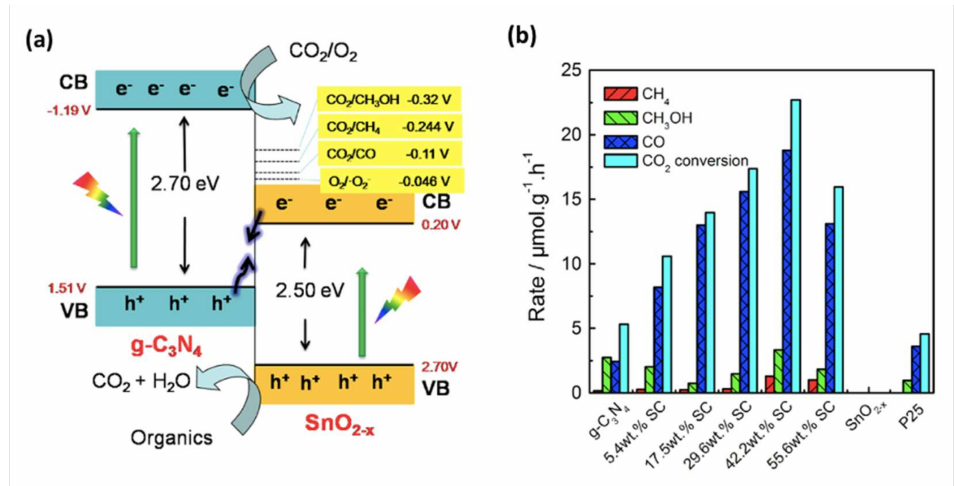
Figure 12. ( a ) Possible schemes for electron–hole separation and transport at composite interface and ( b ) photocatalytic activities of materials on CO 2 photoreduction under simulated sunlight irradiation. Reproduced with permission from Ref. [133]. Copyright 2015